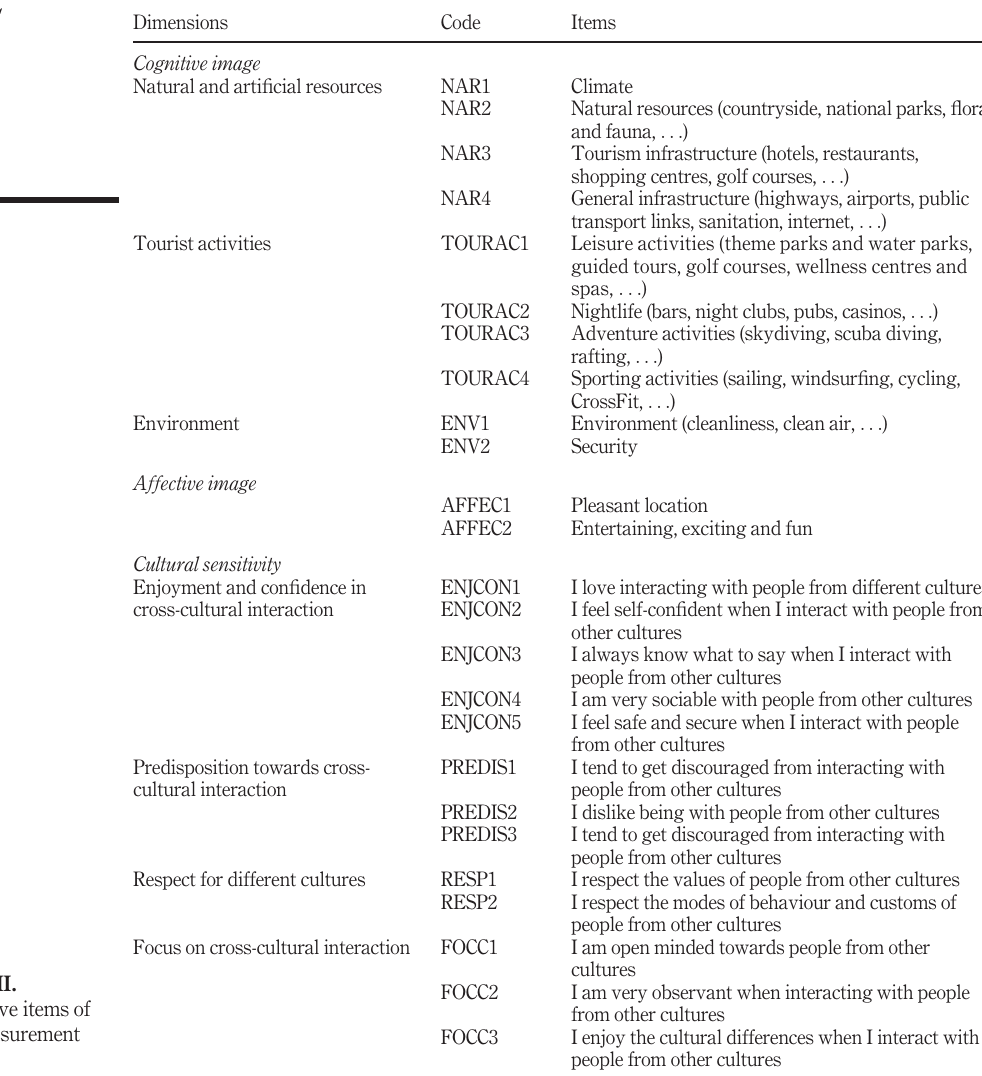
Table II. De fi nitive items of the measurement